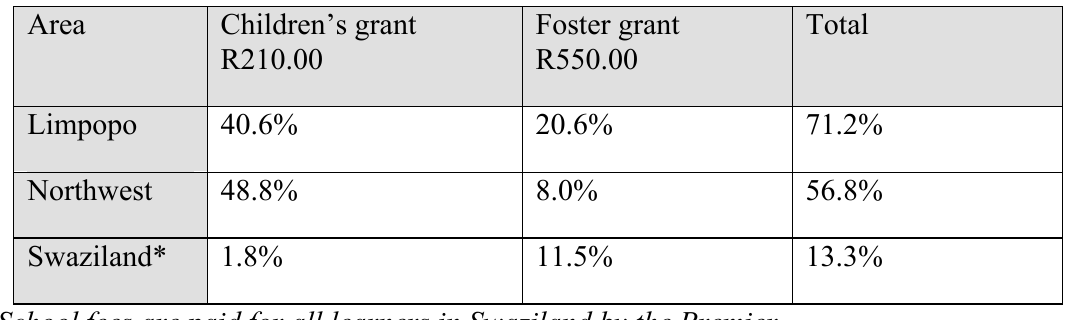
Table 2. Orphans who receive a